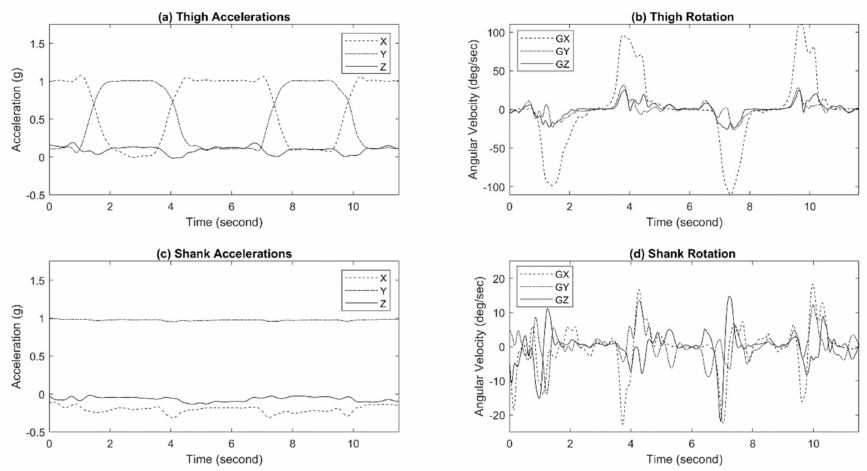
Figure 13. Exo-skeleton IMU responses during sit-to-stand/stand-to-sit